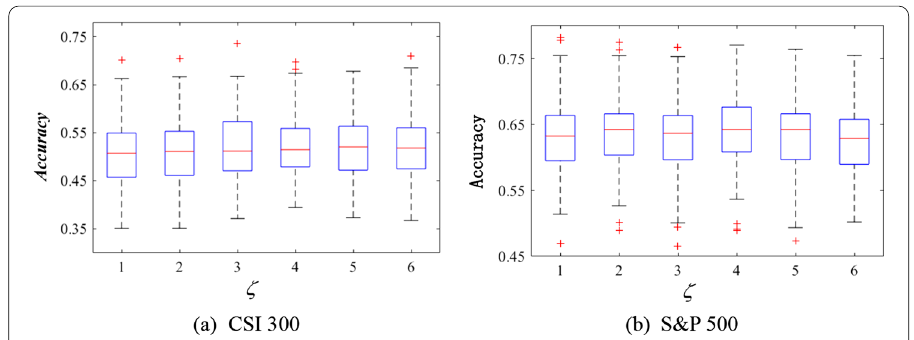
Fig. 8 Prediction accuracy under different values of ζ in each stock set